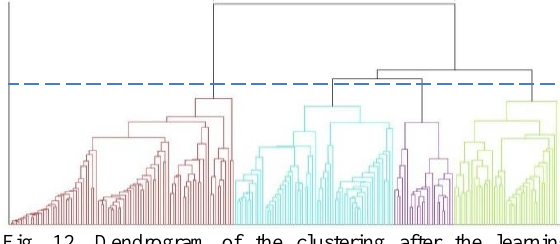
Fig. 12. Dendrogram of the clustering after the learning